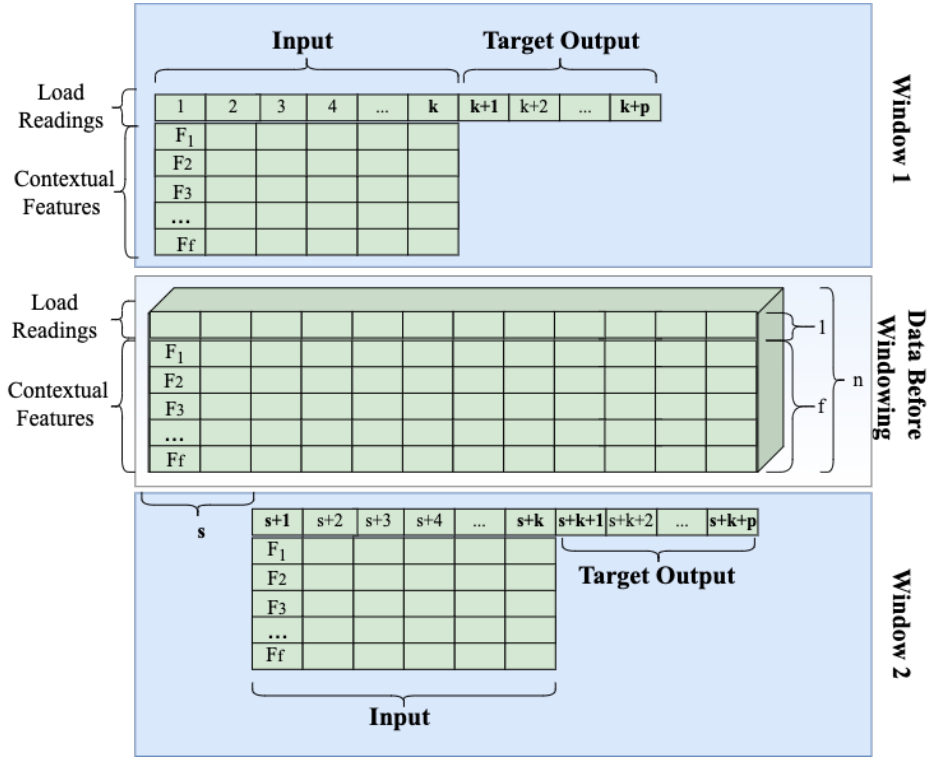
Figure 2. Overlapping sliding window with contextual